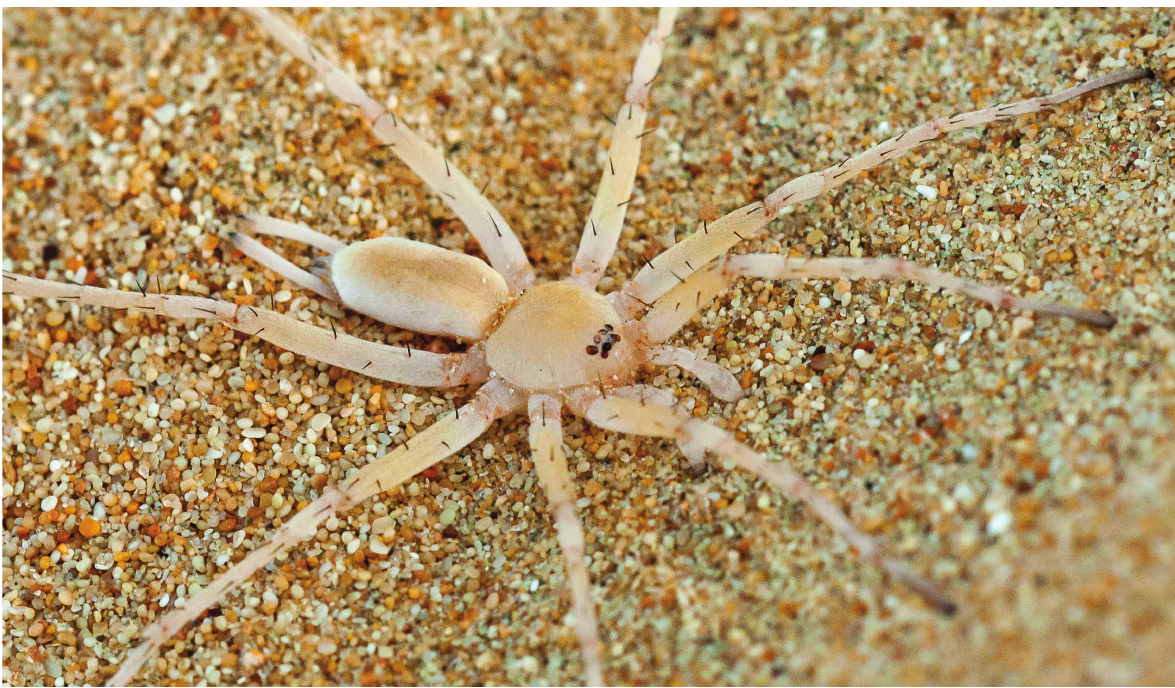
Figure 6. Live habitus of Pterotricha arabica sp. n., sub adult male, Dubai Desert Conservation Reserve, about 75 km SE of Dubai city. Photo by Priscilla Van